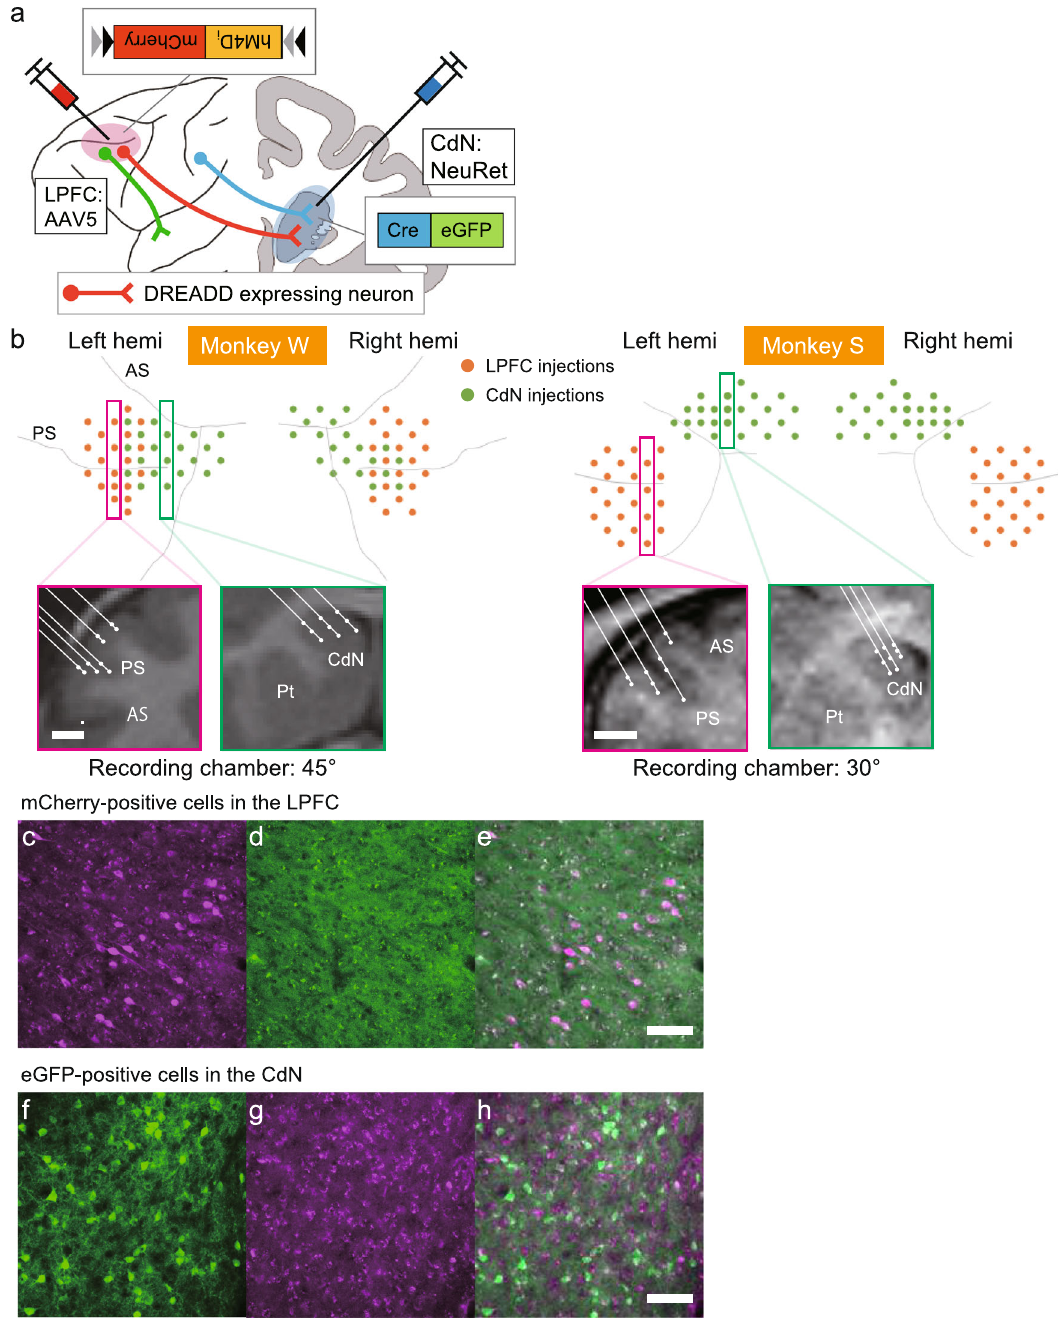
Fig. 1 Chemogenetic double virus transduction and injection sites in the LPFC and CdN. a Illustration of the chemogenetic double virus transduction method. The locally transducing virus (AAV5-hSyn-DIO-hM4D i -mCherry) was injected into the LPFC, while the retrograde virus (FuG-E(NeuRet)-nls/Cre- 2A-eGFP) was injected into the CdN. Only doubly-transduced neurons whose cell bodies were in the LPFC and axon terminals in the CdN expressed the hM4D i -mCherry gene. The activity of these doubly-transduced neurons could be suppressed by CNO administration. b Injection sites of the two viruses. Above: View of virus injection tracks from the diagonal direction for Monkey W (left) and Monkey S (right). Orange dots indicate AAV injection tracks in the LPFC. Green dots indicate NeuRet injection tracks in the CdN. Below: Representative 2D coronal reconstructions of injection positions (white dots) in the LPFC and CdN, corresponding to the tracks boxed in the upper panels. Scale bar: 5 mm. c Doubly-transduced, mCherry-positive neurons (magenta) in the right LPFC as observed using a WIG fi lter cube and d the micrograph of the same area as ( c ) as observed using a NIBA fi lter cube. e The superimposed image of ( c ) and ( d ). Scale bar: 100 µ m. f eGFP-positive neurons (green) in the ipsilateral CdN of Monkey S. g Micrograph of the same area as in ( f ). h The superimposed image of ( f ) and ( g ). Scale bar: 100 µ m. AAV adeno-associated virus, LPFC lateral prefrontal cortex, PS principal sulcus, AS arcuate sulcus, CdN caudate nucleus, Pt putamen, DREADD Designer Receptors Exclusively Activated by Designer Drugs.